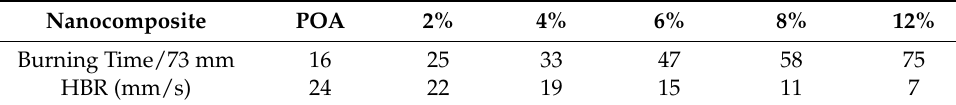
Figure 6. TGA/DSC of pure POA ( a , b ), and MMT/POA at 6% ( c , d ). Table 2. The horizontal burning rates for MMT/POA